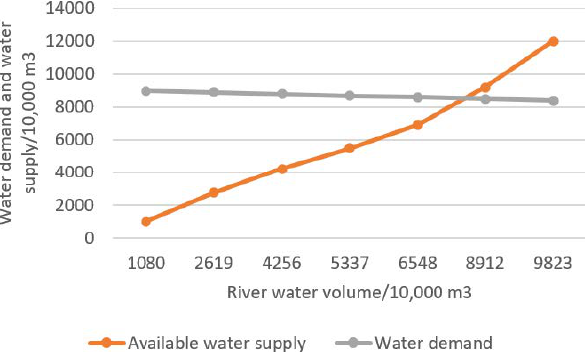
Fig. 2 The relationship between the available water supply, water demand, and the water volume of the Songhua River analysis. There is an optimal balance for the amount of water in the Jacques Songhua River. The water supply